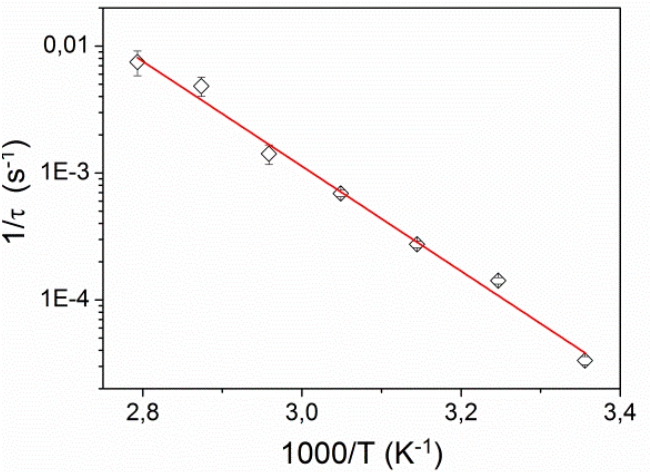
Figure 7. Inverse relaxation time 1/ τ as a function of inverse temperature. The solid line is a fit to the Arrhenius